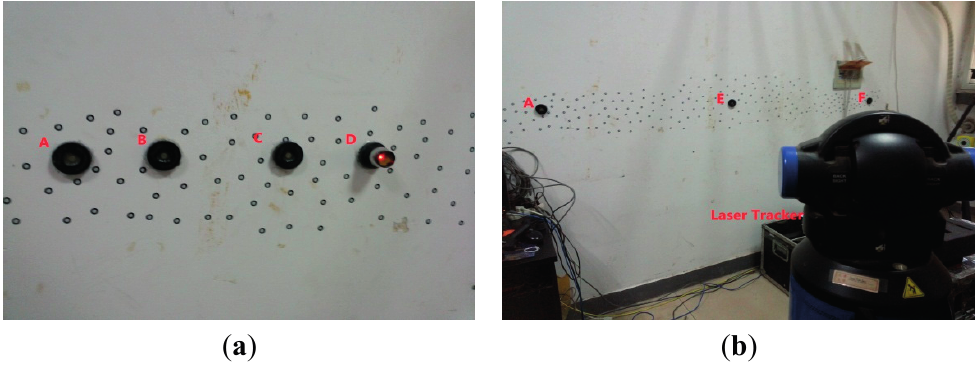
Figure 5. The standard values of the distances between the points measured by the laser tracker. ( a ) The measurement of AB, AC and AD; ( b ) The measurement of AE and AF.